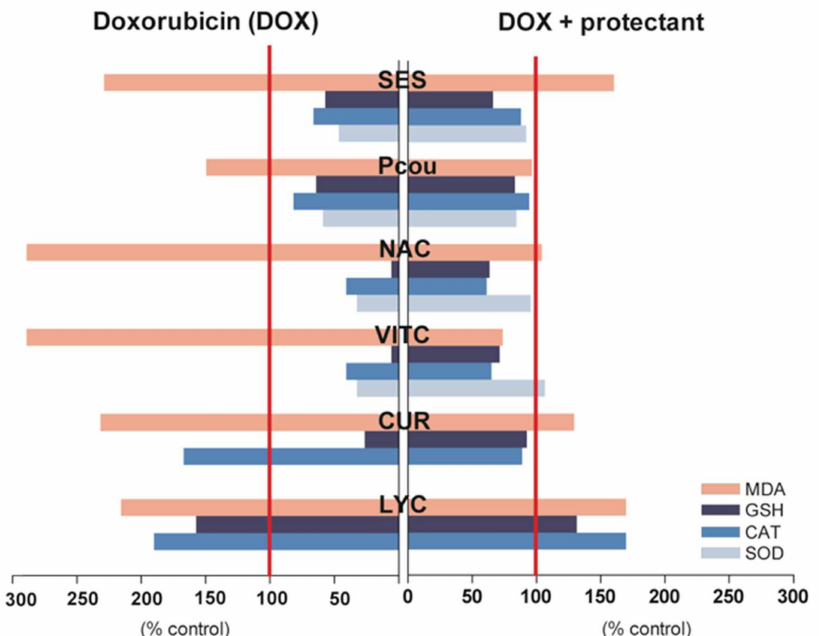
Figure 2. The oxidative-stress-associated cardiotoxic effects of DOX (left-hand side bars) are com- pared with cardioprotective activity of bioactive phytochemicals (right-hand side bars). Phyto- chemicals decreased MDA formation stimulated by DOX (control MDA values ranged from 57.7 to 1179 nmol/g protein). The tested cardioprotectants restored the level of GSH reduced by DOX (control GSH values range was from 0.01 to 99.8 µ mol/g protein), as well as normalized activity of antioxidant enzymes SOD and CAT (100% CAT and SOD were in the range of 5.82 to 12.35 U/mg protein and from 1.10 to 8.69 U/mg protein,